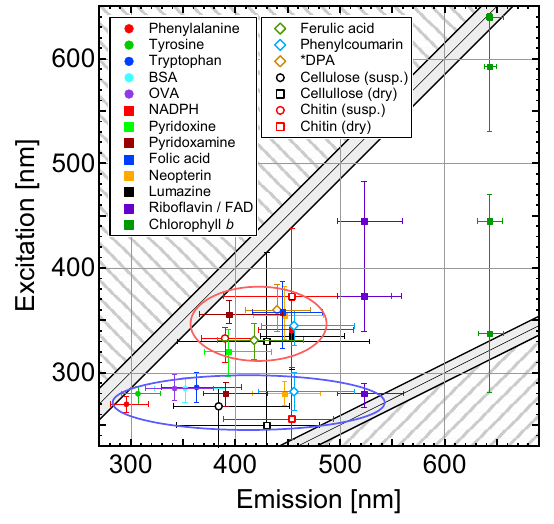
Fig. 3. Overview EEM mapping the spectral position of biological fluorophores. Protein fluorophores are represented by solid circular markers, coenzyme fluorophores by solid square markers and struc- tural fluorophores by open markers. Full width half max (FWHM) of emission peaks is represented by horizontal and vertical bars. Differences in relative fluorescence intensity are neglected. For multimodal fluorophores all modes are shown. Data refer to mea- surements of solved fluorophores in PBS. For cellulose and chitin results of solid state and suspension state spectra are shown. ∗ Data for DPA are taken from Sarasanandarajah et al.